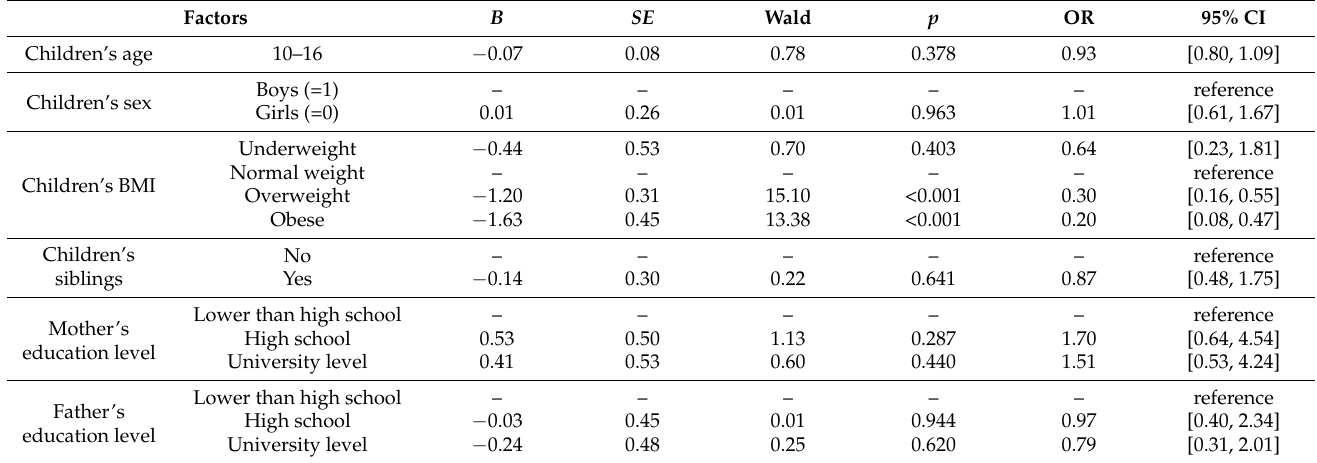
Table 2. a. Predictors of parents’ accuracy in identifying children’s weight category ( n = 343 1 ).